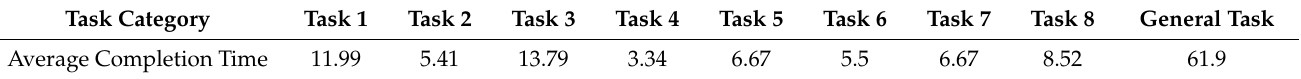
Table 7. Multi-channel improved MR display interactive system to perform the average task time.